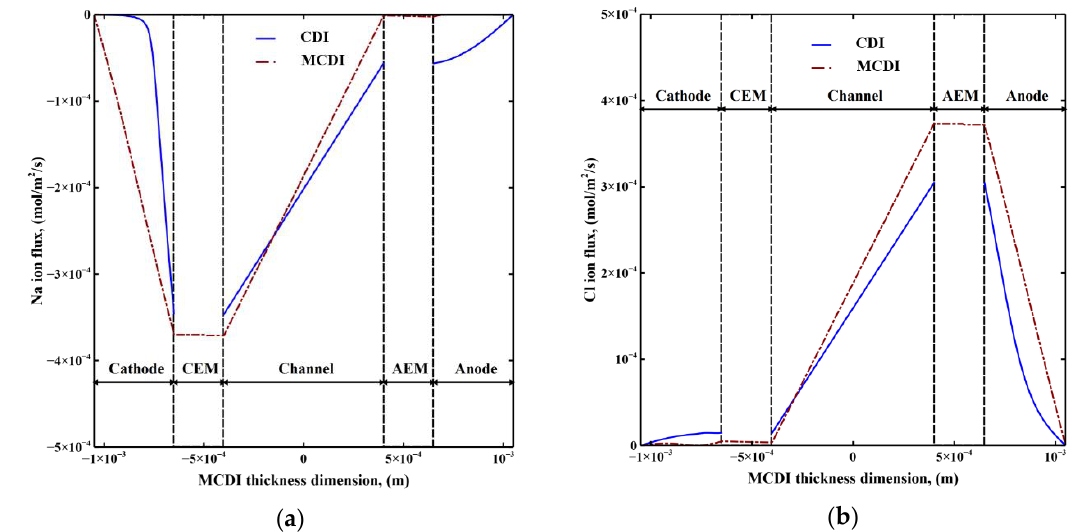
Figure 5. ( a ) Sodium ion flux distribution and ( b ) chloride ion flux distribution along the cross-sectional line of CDI and MCDI at t = 50 s. The applied voltage is 0.8 V, the flow rate is 10 mL / min, and the feed water concentration is 20 mol / m 3 .